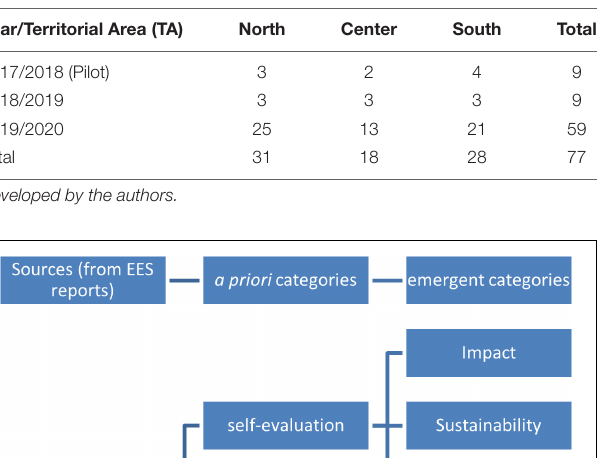
TABLE 1 | Distribution of external evaluation of schools’ (EES) reports by school years and territorial areas (TAs).